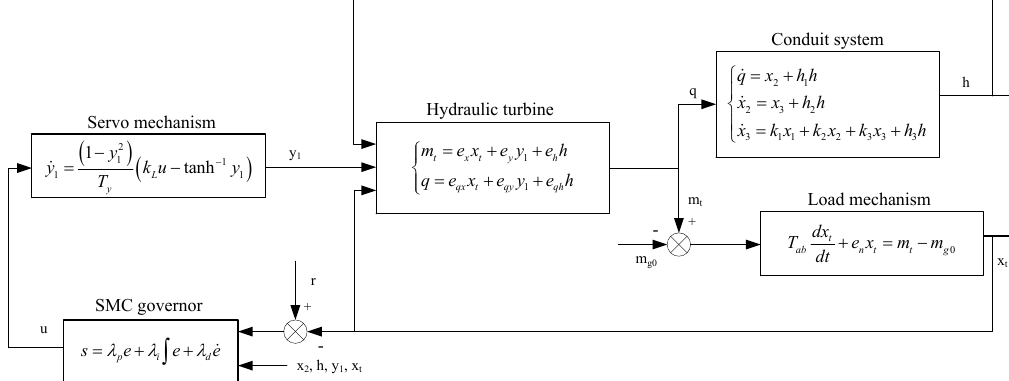
Figure 2. HTGS system governed by